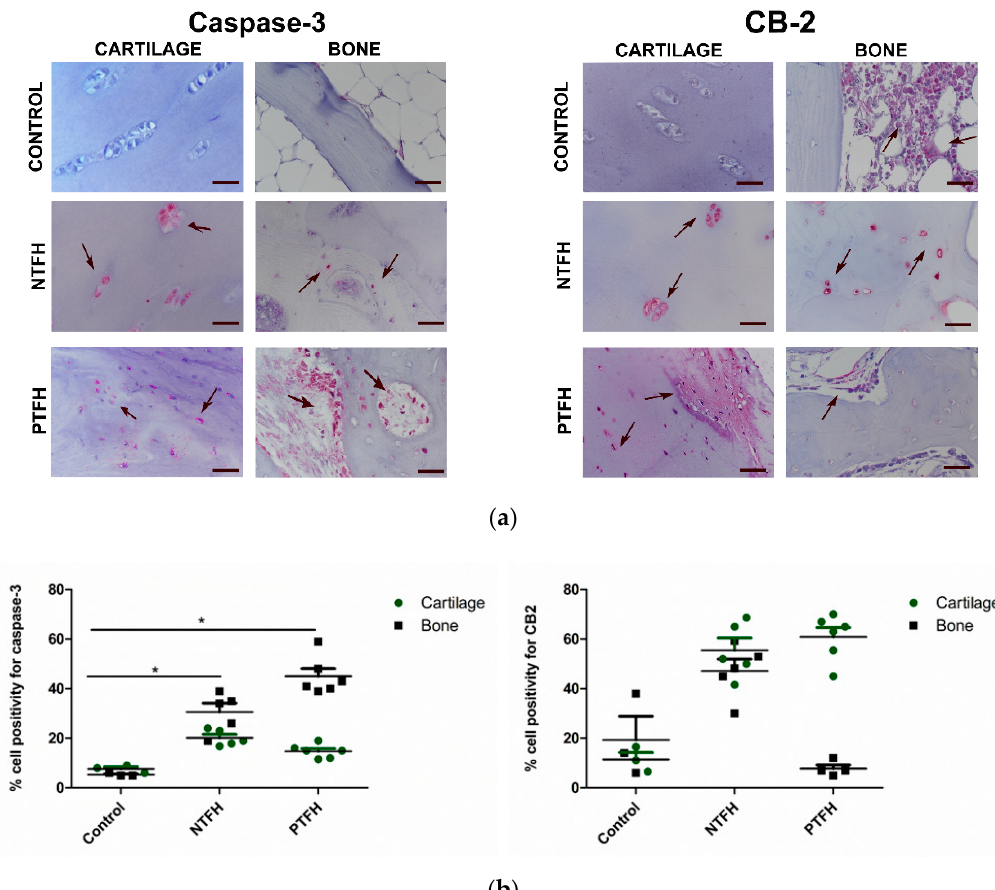
Figure 3. ( a ) Immunostaining for caspase-3 and CB-2 of the control, NTFH and PTFH groups. Scale bar = 50 µ m. Black arrows show positive cells. ( b ) Graphical representations of the percentage of positivity for caspase 3 and CB-2. Data are expressed in a scatter plot graph with mean ± standard deviation (SD). Caspase 3: * p < 0.05: Control versus NTFH group; * p < 0.05: NTFH versus PTFH group.